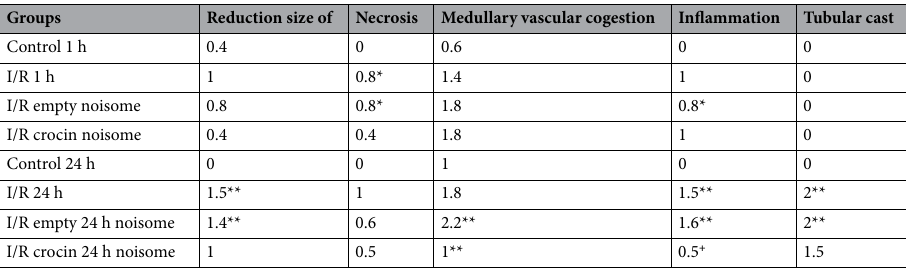
Table 1. The effect of niosomal formulation contain crocin on I/R-induced morphological changes followed by 1 h and 24 h of reperfusion. * P < 0.05, **P < 0.01 versus control; + P < 0.05 versus I/R and I/R + empty niosome group.